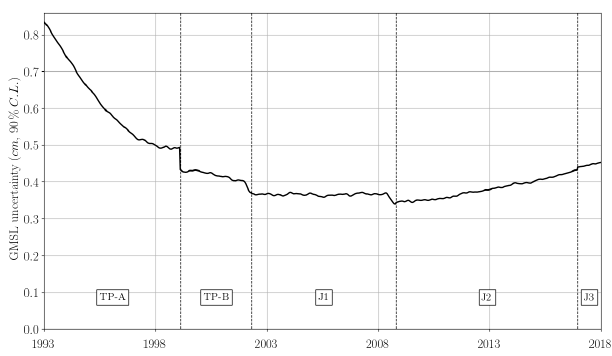
Figure 3. Evolution in time of GMSL measurement uncertainty within a 90% confidence level (1 . 65 σ ) on the 25-year period (Jan- uary 1993 to December